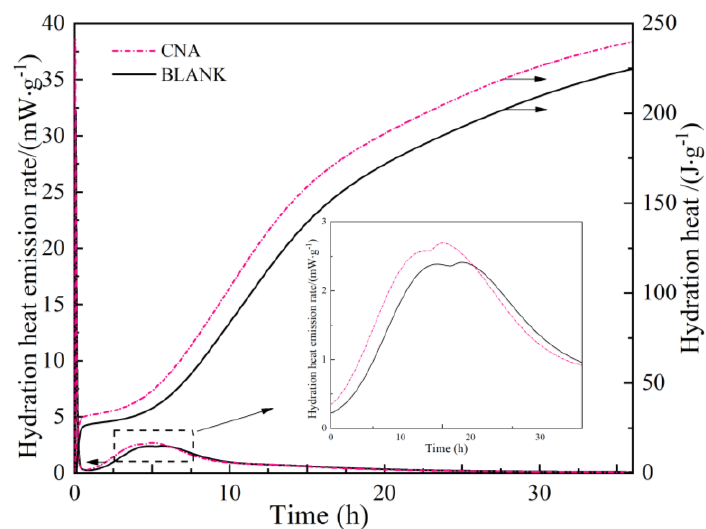
Figure 3. Cement hydration rate and heat of hydration curve.